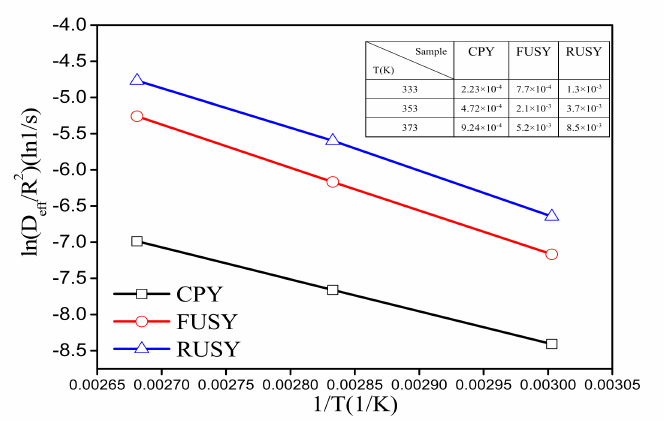
Figure 4. The relationship between the effective diffusion time constant and temperature at 333 K, 353 K, and 373 K for methylcycloheane (MCH) on the three Y-zeolite